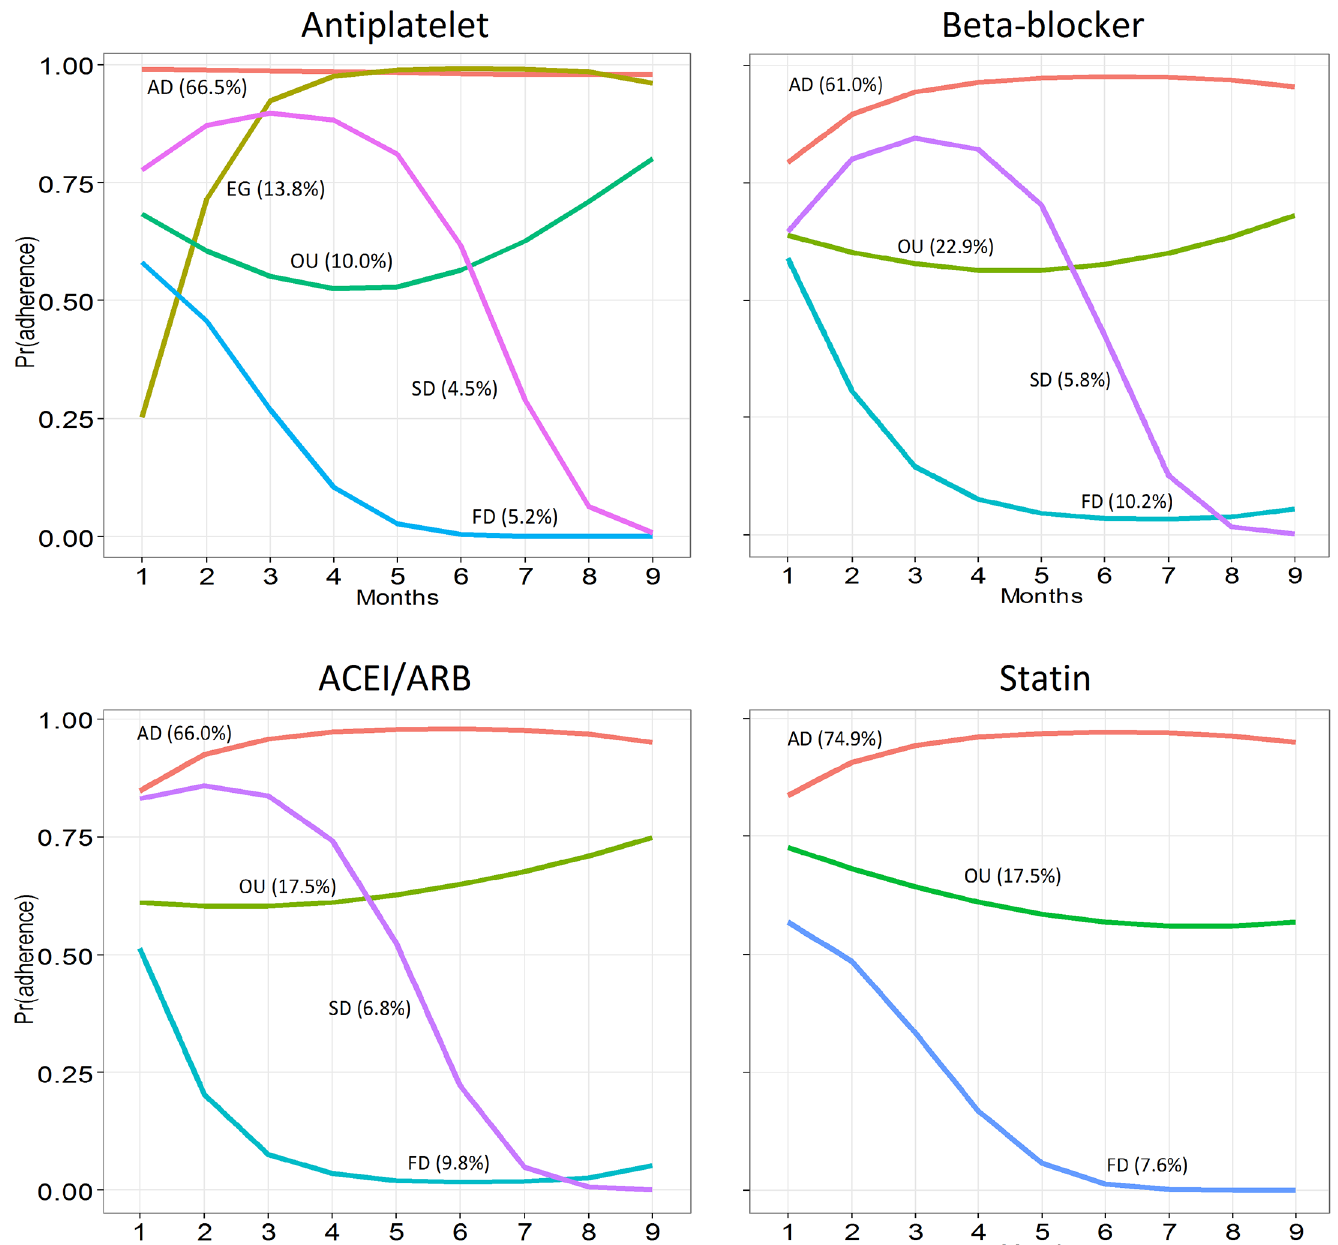
Fig 1. Adherence trajectory patterns for the four cohorts. AD: adherent; EG: early gap; OU: occasional users; SD: slow decline; FD: fast decline, ACEI: angiotensin-converting enzyme inhibitors; ARB: angiotensin receptor blockers.